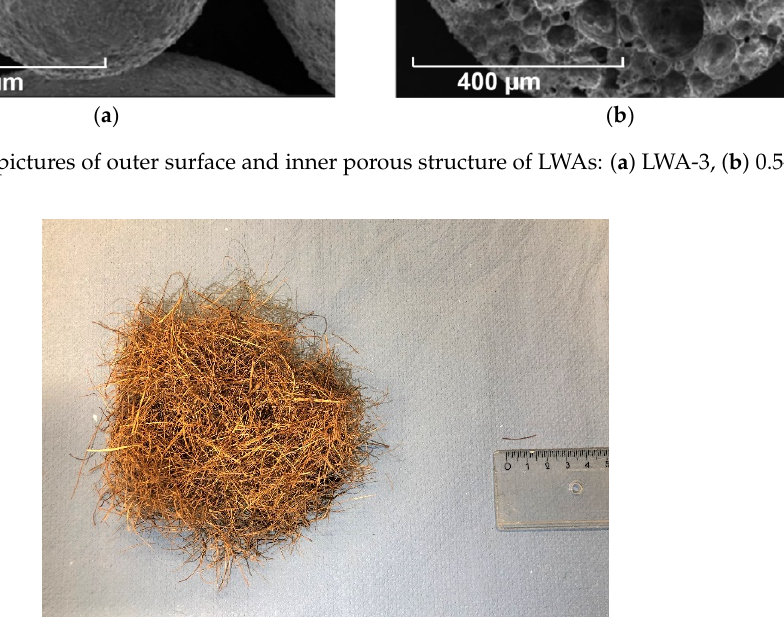
Figure 4. Appearance of coir fibers. The average length of coir fibers is about 15 mm. Table 1. Physical and chemical properties of coir fiber.